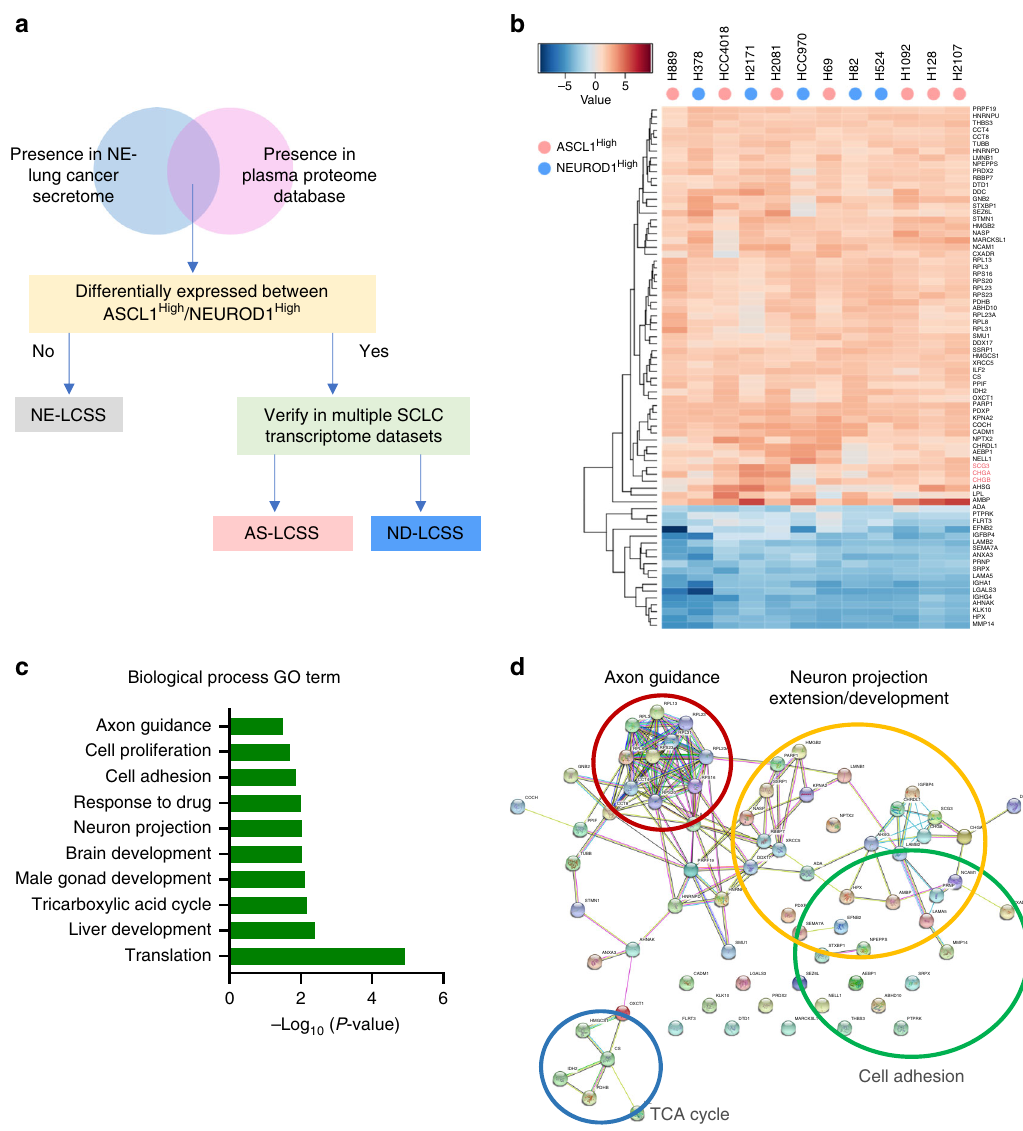
Fig. 2 Generation of a NE-lung cancer-speci fi c secretome signature (NE-LCSS). a Overview of the methodology to prioritize the candidate biomarkers for NE-LCSS, AS/ND-LCSS. b Heatmap showing the expression of the NE-LCSS across the 12 NE-lung cancer cell lines used in the secretome MS analysis. Pink dots indicate the ASCL1 High cells, and blue dots indicate the NEUROD1 High lines. Three known secreted markers for NE-Lung cancer (SCG3, CHGA, and CHGB) are highlighted in red. c P- value of the highly represented GO biological process terms for the NE-LCSS. d Protein – protein interaction network of NE-LCSS. Source data are provided as a Source Data fi